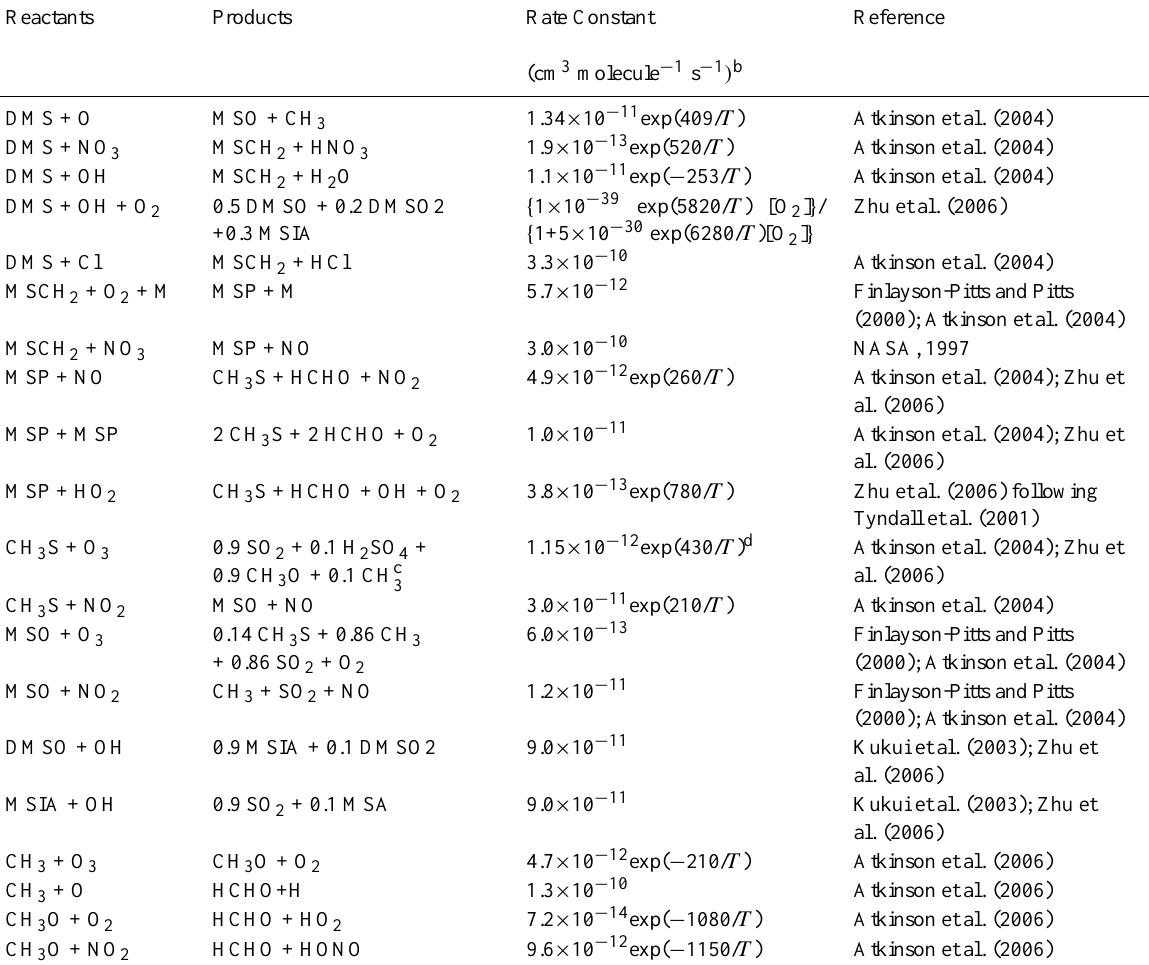
Table 3. Reactions added to CB05 for organic sulfur species and their reaction products a